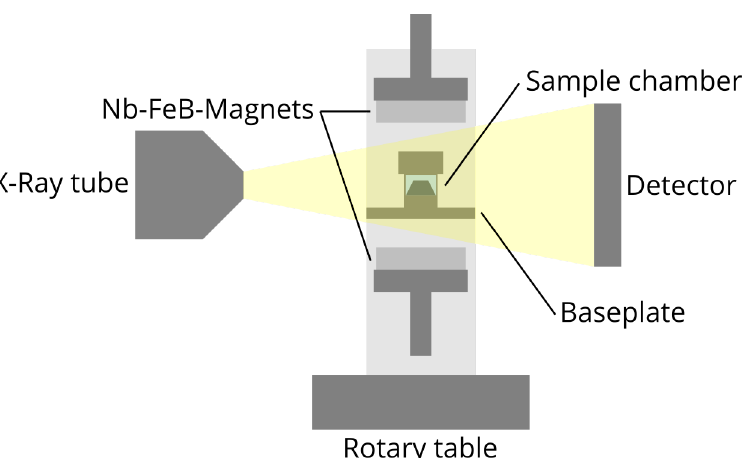
Figure 1. Draft of the tomographic setup. The sample is within a sample chamber with storage solu- tion. Two Nb-FeB-magnets are used to generate a magnetic field at the sample position. The magnetic flux density is adjusted by the distance of the magnets and the sample. The sample holder is placed on a rotary table between the X-ray tube and the